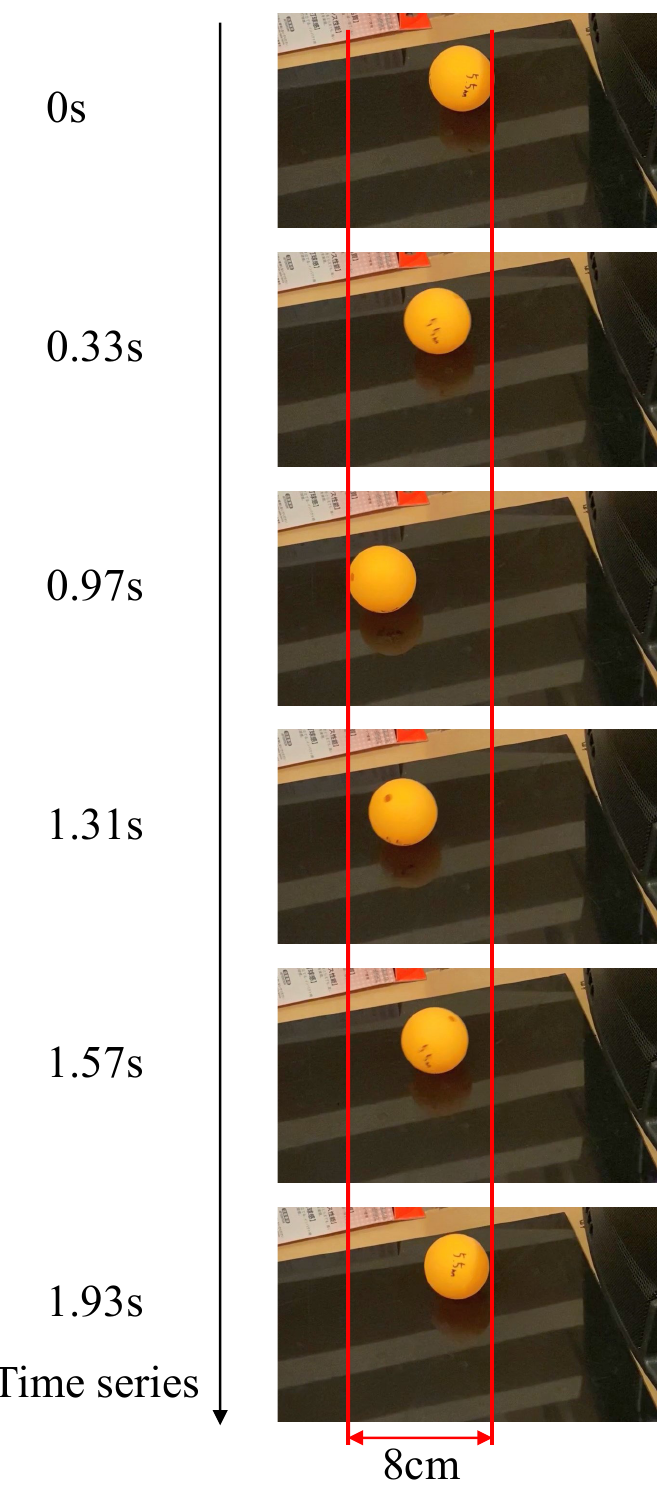
Figure 10. Actual movement of a ball with nothing attached.